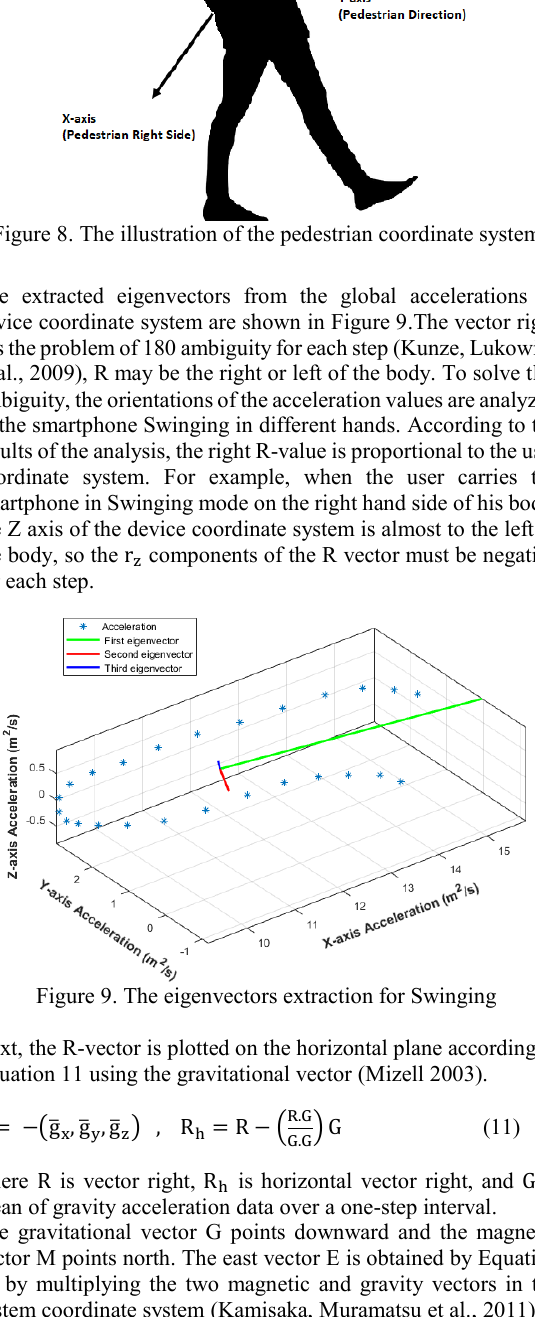
mean of gravity acceleration data over a one-step interval. The gravitational vector G points downward and the magnetic vector M points north. The east vector E is obtained by Equation 12 by multiplying the two magnetic and gravity vectors in the system coordinate system (Kamisaka, Muramatsu et al.,